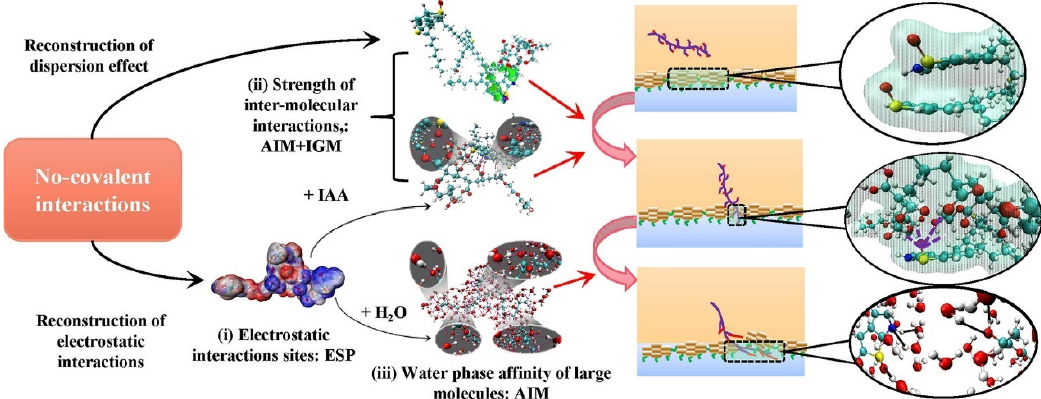
Figure 32. The non-covalent interactions in heavy oil–water separation. Reprinted with permission from Ref. [213]. Copyright 2022, copyright the Elsevier. More details on Copyright and Liscensing are available via the following link: https://www.sciencedirect.com/.